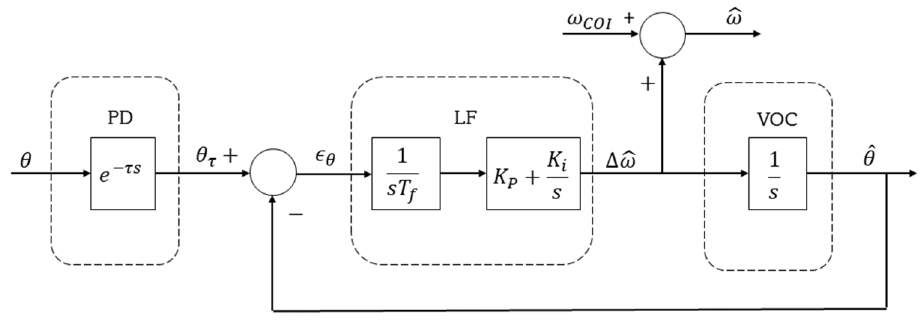
Figure 5. Diagram of the